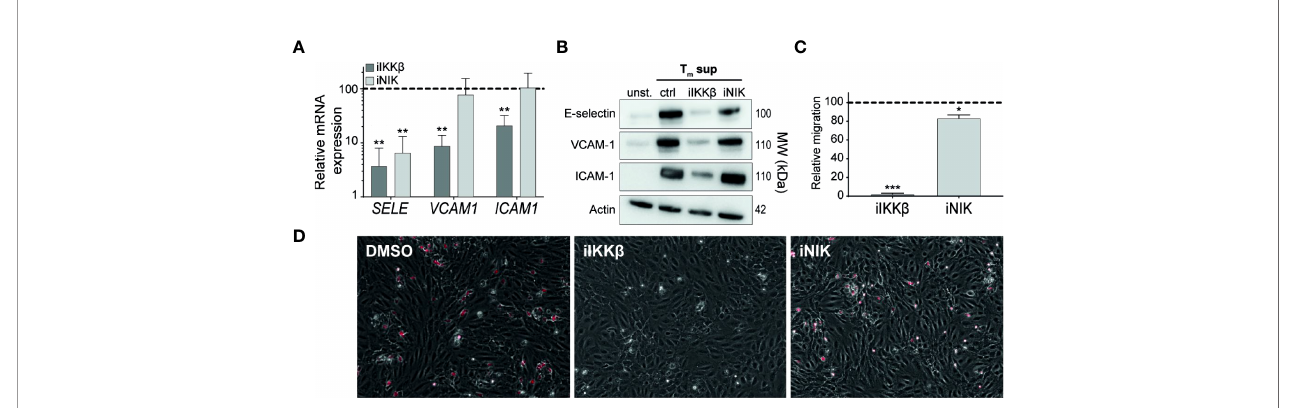
FIGURE 6 | IKK b is the main regulator of neutrophil adhesion and transendothelial migration. (A, B) ECs were left unstimulated or stimulated with T m sup for 72h and treated with iIKK b ,iNIK or DMSO (control). (A) Quanti fi cation of indicated mRNA transcripts by qPCR ( n =5). (B) Representative western blot image of indicated proteins. (C, D) ECs were stimulated for 24h with T m sup and treated with iIKK b , iNIK or DMSO (control). Next, a transmigration assay was performed with neutrophils. (C) Quanti fi cation of neutrophil migration and (D) representative images for indicated conditions; neutrophils attached to ECs are depicted in red. Dark gray; iIKK b , light gray; iNIK. Values are shown relative to control (dashed line). *p < 0.05, **p < 0.01, ***p <